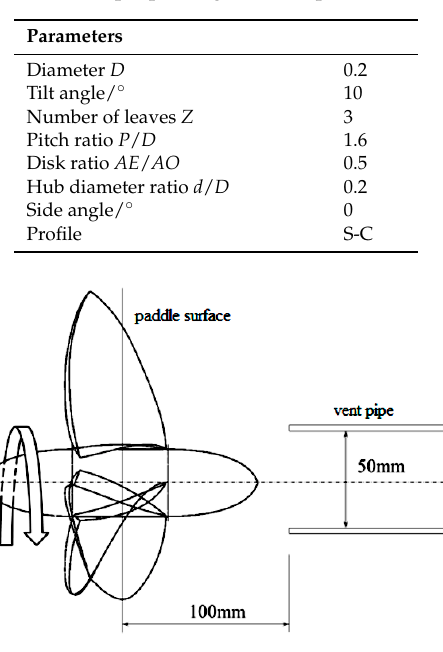
Figure 1. The submergence ratio of surface-piercing propellers (SPPs), which is defined as the ratio of the immersion depth h to the propeller diameter D .